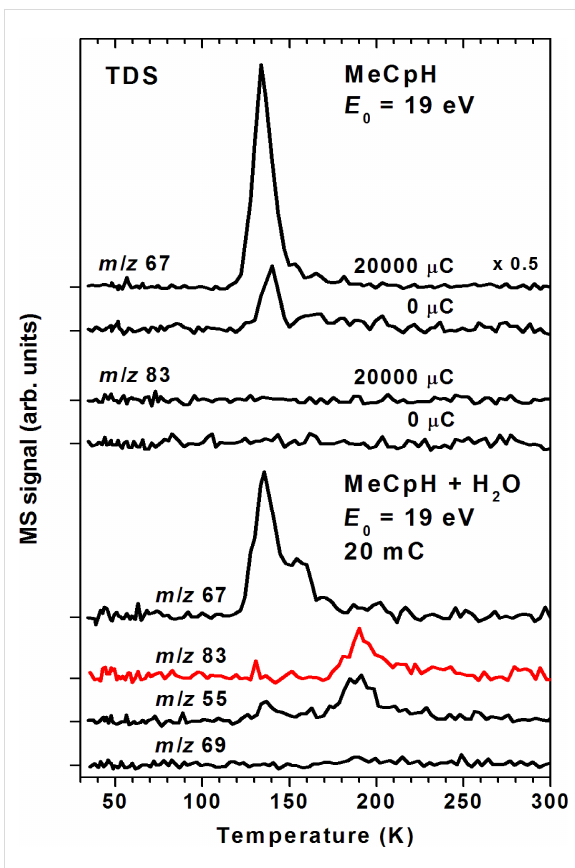
Figure 10: Thermal desorption spectra from condensed layers of MeCpH with estimated thickness corresponding to 15 monolayers on a Au substrate recorded before and after an electron exposure of 4 mC/cm 2 at E 0 = 19 eV with the substrate held at 35 K (top) and of a mixed condensed layer of MeCpH and H 2 O (1:1) with estimated thick- ness corresponding to 20 monolayers on the same substrate recorded after an electron exposure of 4 mC/cm 2 at E 0 = 19 eV with the sub- strate held at 35 K (bottom). See text and Table 1 for explanations on selection of m / z ratios shown here.